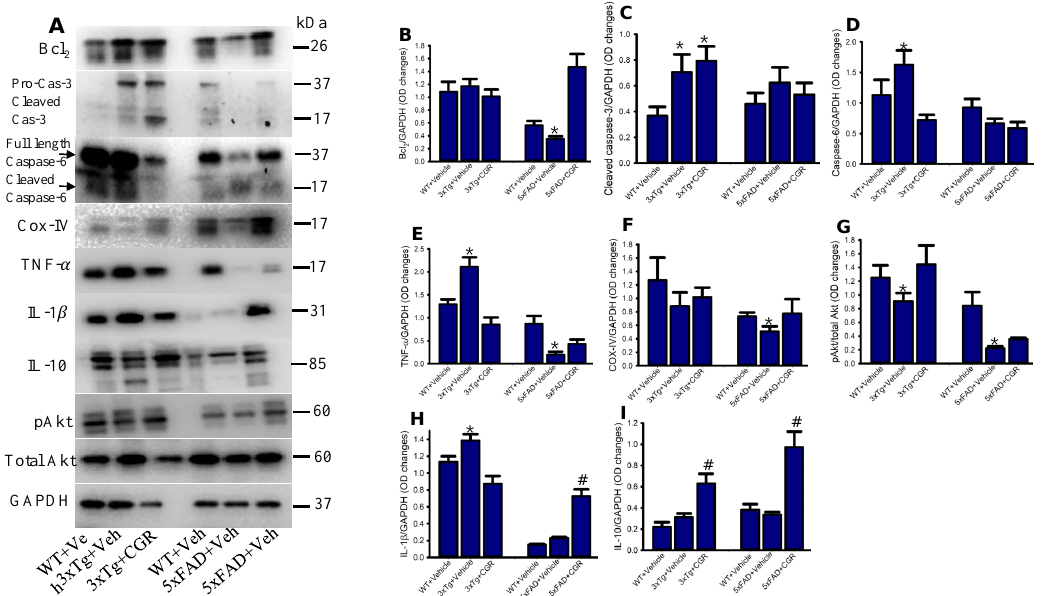
Figure 13. Curcugreen treatment reduced pTau, cell survival- and cell death and inflammatory markers in the spleen tissue from 3xTg and 5xFAD mice. Flash frozen spleen tissue from both 3xTg and 5xFAD mice were homogenized with an ice cold RIPA buffer with protease and phosphatase cocktail. Total protein was measured by BCA method and equal amounts of proteins were loaded and separated by sodium dodecyl sulphate gel electrophoresis (SD-PAGE), transferred to the